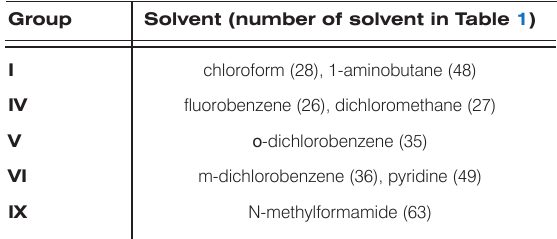
Table 5. Classification of solvents from the third testing set.